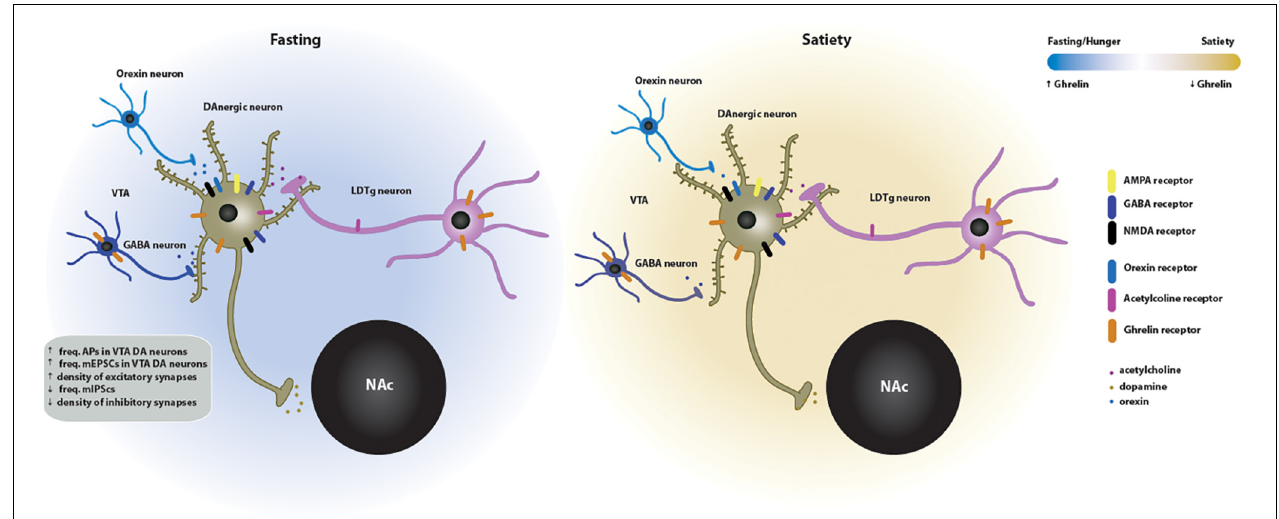
FIGURE 3 | Effects of ghrelin on synaptic plasticity in the VTA → NAc circuit of the mesolimbic system. Two energy states are represented: fasting/hunger and satiety. In the fasted state, ghrelin increases the neuronal activity and the density of excitatory synapses of dopaminergic neurons in the VTA. This increase in VTA dopaminergic activity triggers the release of dopamine onto the NAc. The ghrelin effects on the VTA synaptic plasticity may be directly mediated since the GSH-R1a is expressed in the VTA DA and GABA neurons. Indirect activation of the VTA-NAc pathway by ghrelin is mediated by orexin, which is released by upstream orexigenic neurons, and by cholinergic afferents from the laterodorsal tegmental area (LDTg), which contain both GSH-R1a and nicotinic acetylcholine receptors in cholinergic presynaptic neurons. GABAergic transmission is also involved in the ghrelin-induced effects on neuronal activity. In the fed state, the VTA neuronal activity and, subsequently, dopamine release on the NAc return to basal